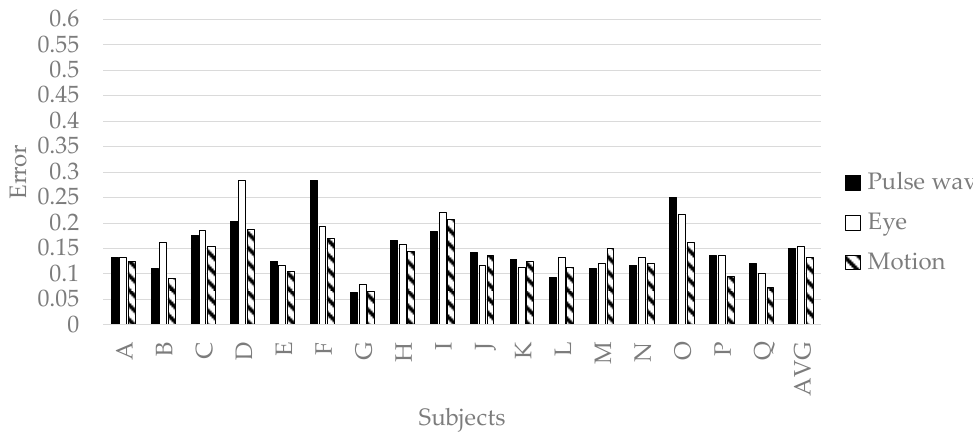
Figure 12. The accuracy of personalized model of engagement.